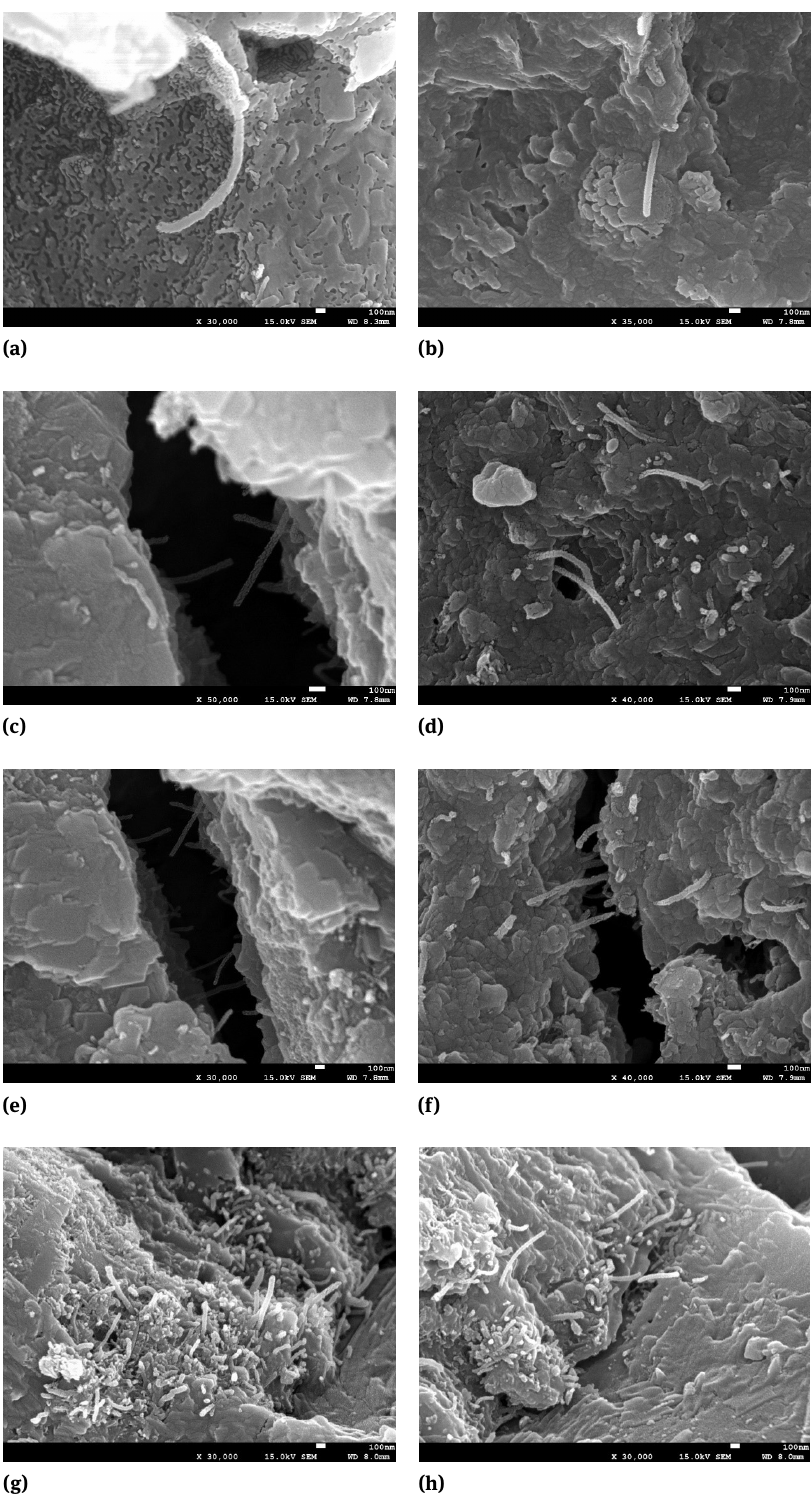
Figure 10: The microstructure of CNT-reinforced UHPC after curing for 28 days: (a) (b) CNT tightly bonded to the matrix (c) (d) CNT with one end fixed and one end free (e) (f) bridging of CNT (g) (h) CNT agglomerated in the